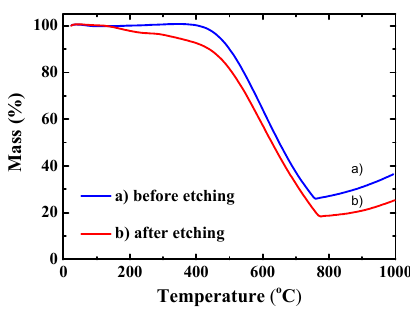
Figure 5. TGA curves of Si/C composites before and after etching.